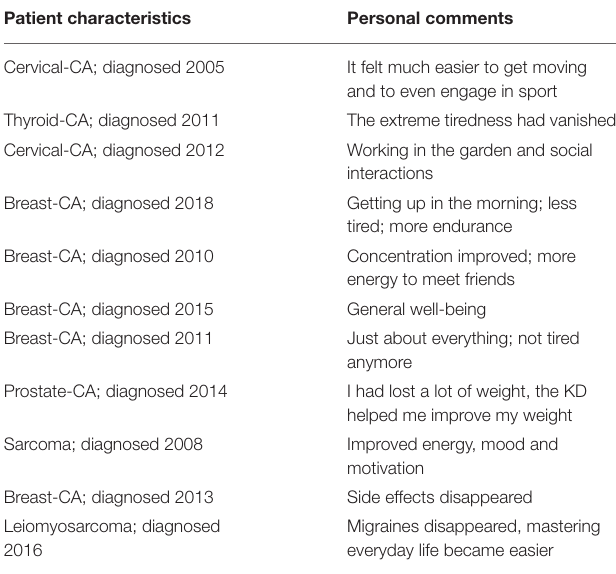
TABLE 4 | Selected comments from participants indicating which aspects of their QoL improved after they changed their